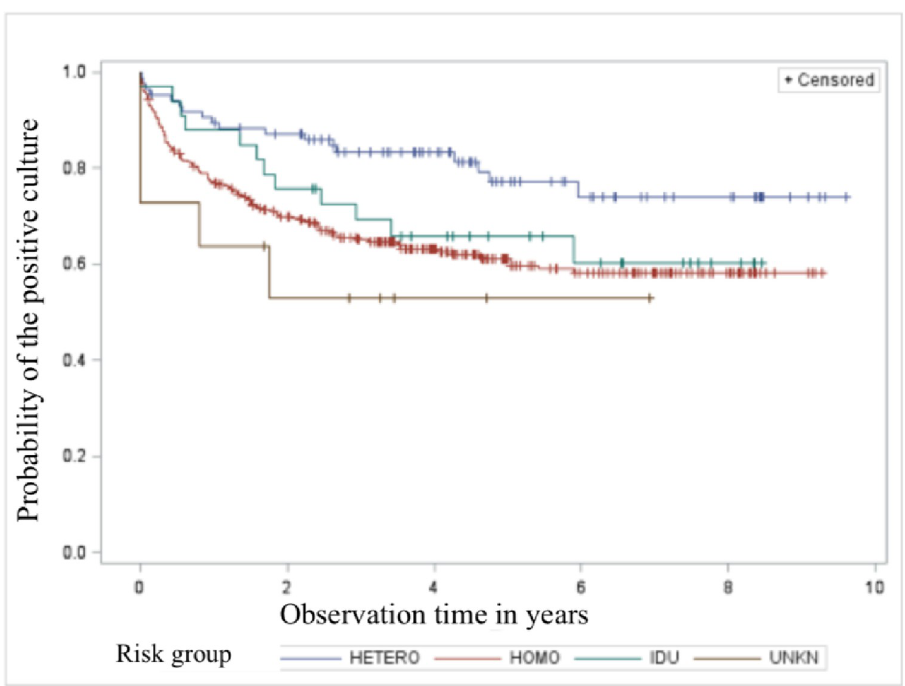
Fig 1. Probability of a positive culture result according to Kaplan Meier with stratification relative to the route of infection (Log-Rank p = 0.0137).